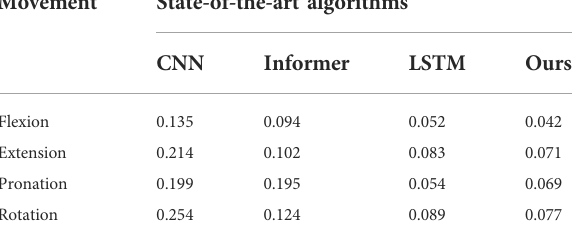
TABLE 3 MSE comparison of different algorithms.